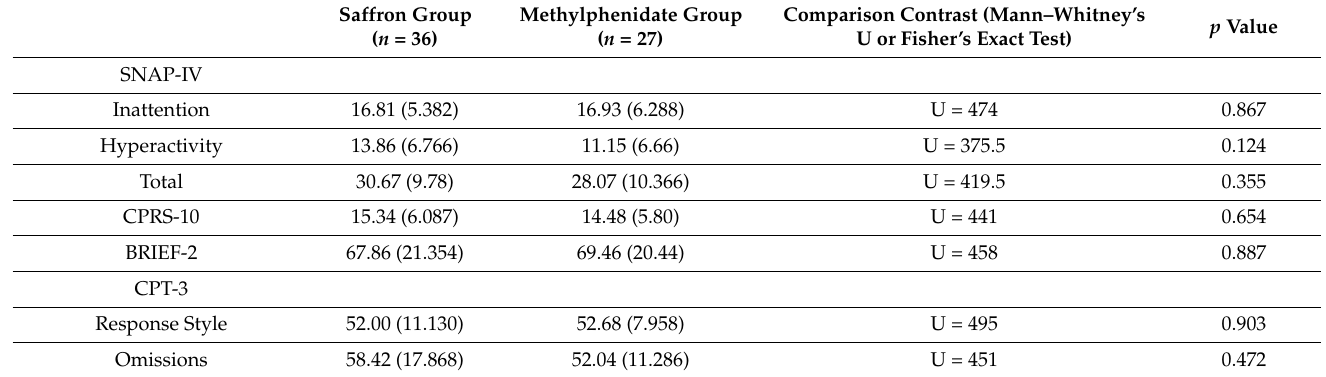
Table 2. Clinical variables and test scores